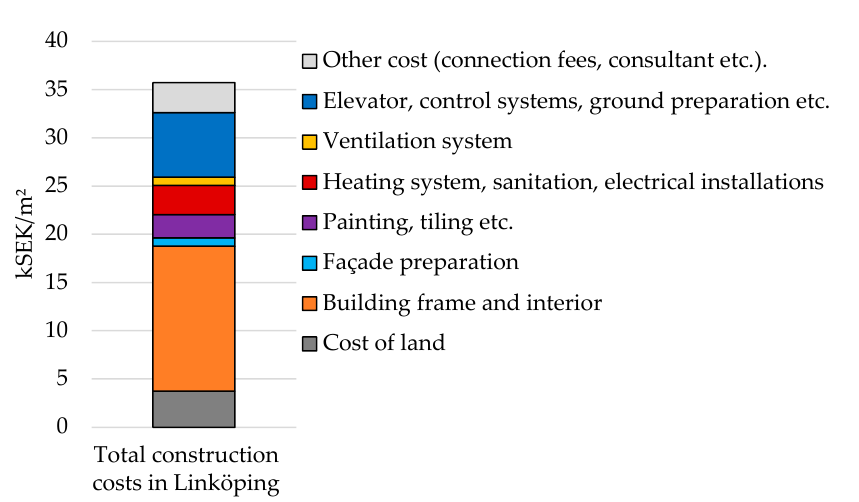
Figure 1. Building costs for newly constructed multi-family buildings in Linköping, Sweden, based on findings from [48] and corrected to current cost based on increase in construction costs in central Sweden [45].